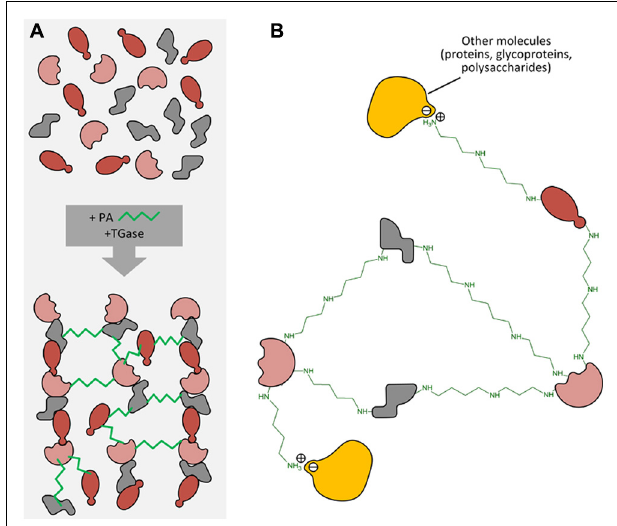
FIGURE 3 | (A) Different protein molecules can form a net by PA linkage catalyzed by transglutaminase. (B) PAs can also form other linkages (i.e., ionic ones) with different molecules such as proteins, polysaccharides, phenols, etc., thus forming heterogeneous